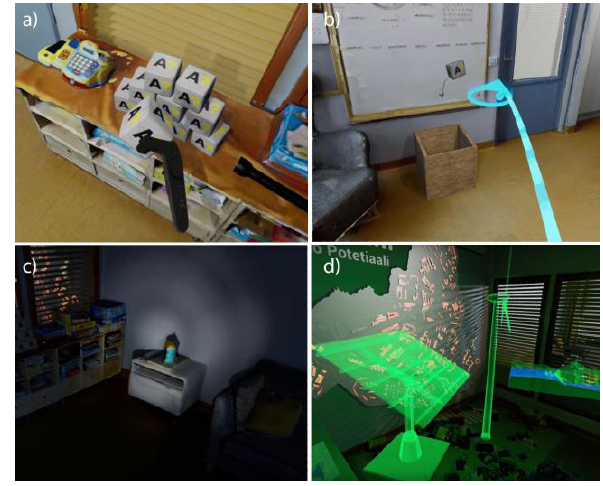
Figure 6. User interaction in the VR scene: (a) User manipulating a construction block, (b) defining a location to teleport to, (c) user exploring the space with a flashlight after turning of the light, and (d) viewing the “holograms” showing energy production